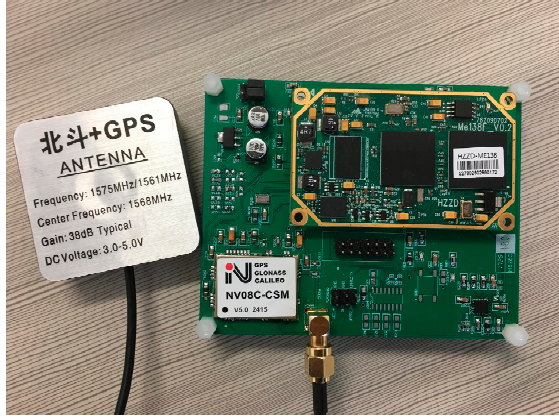
Figure 6. Hardware platform.